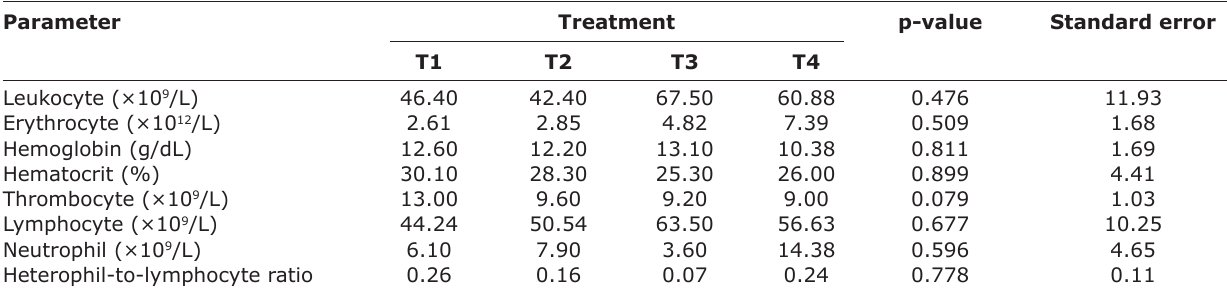
Table-4: Hematology of Pengging duck which given symbiotic (inulin of gembili tuber and Lactobacillus plantarum ).